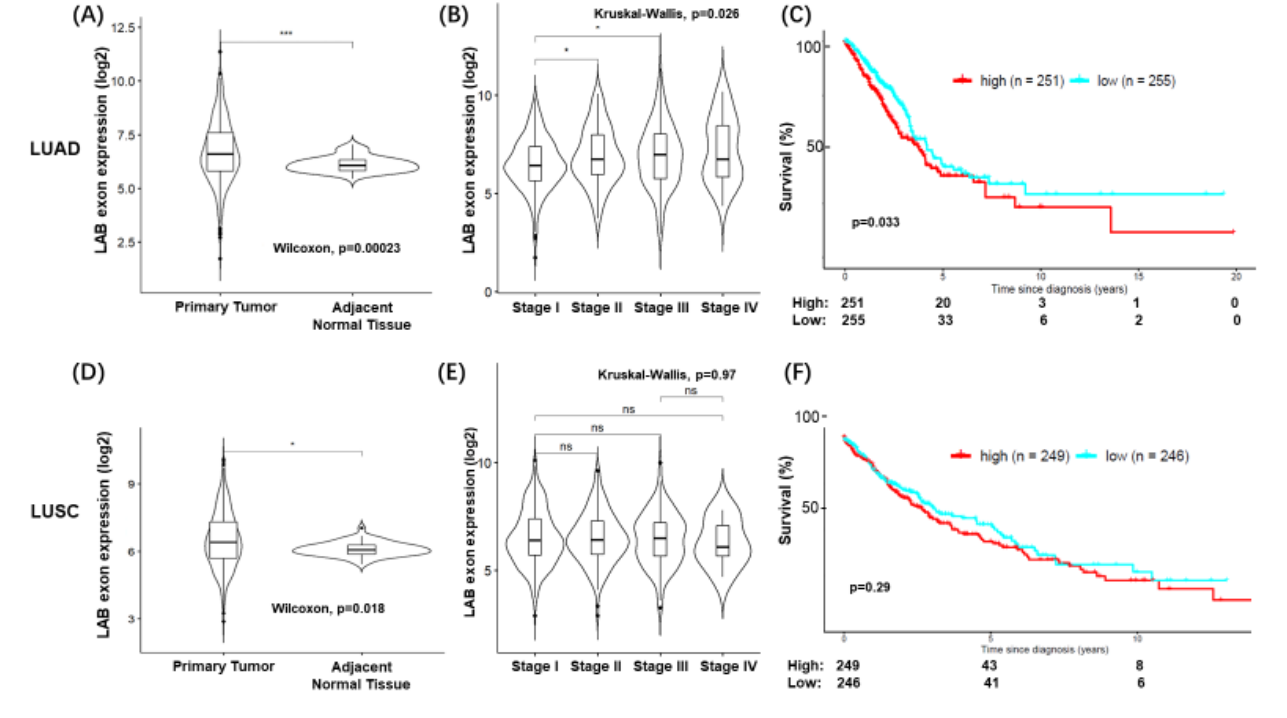
Figure 6. LAB RNA expression in TCGA. Average LAB exon RNA expression was assessed in the TCGA LUAD. Violin plots of average LAB expression in LUAD by tissue type ( A ) or cancer stage ( B ). Pairwise statistical differences assessed by Wilcoxon rank sum test (Mann–Whitney U test) and one-way ANOVA by Kruskal–Wallis tests. ( C ) Kaplan–Meier curves depicting overall survival or patients with higher median LAB RNA expression. Number at risk table shown below. Log-rank test used to evaluate significance. Same analyses applied to TCGA LUSC ( D – F ). * p < 0.05 and *** p < 0.001 for statistical significance. ns for no statistical significance.